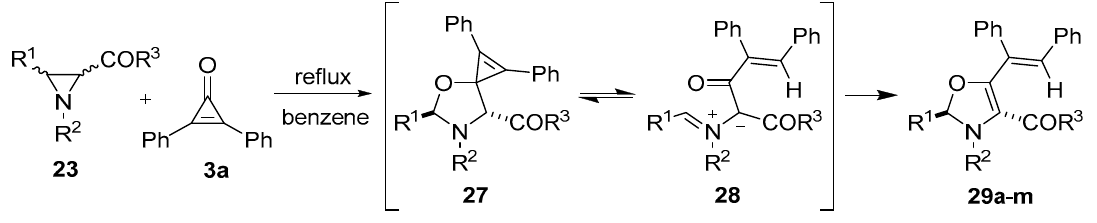
Table 3. Cycloaddition of the azomethine ylides derived from aziridines 23 to diphenylcyclopropenone ( 3a ) (Scheme 5).